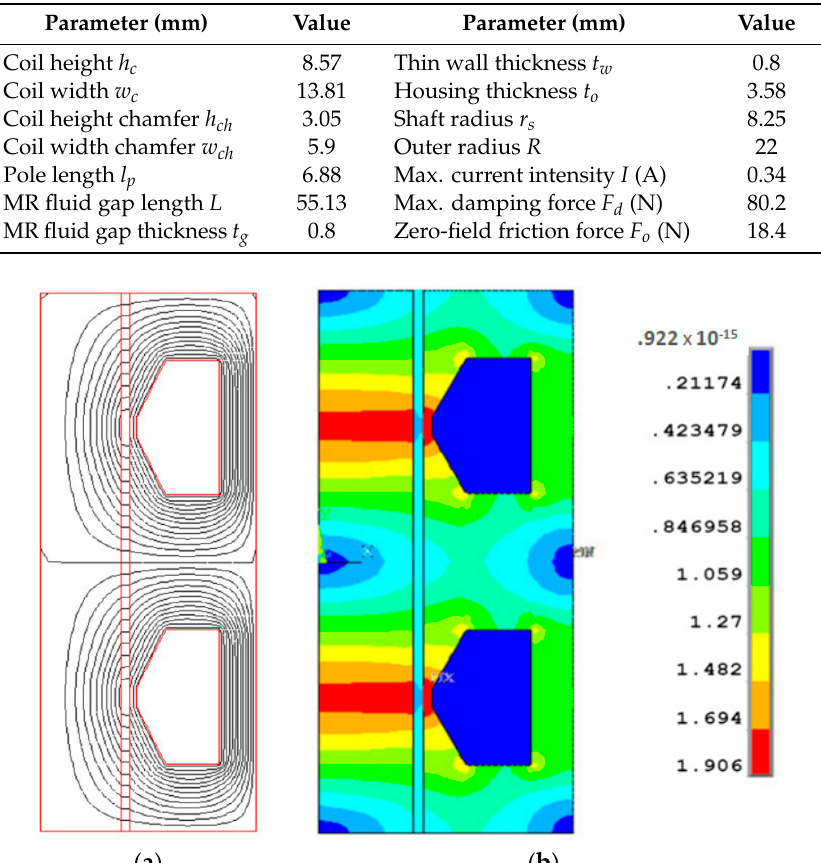
Figure 10. Finite element analysis of the optimized MR damping part: ( a ) magnetic flux line and ( b ) magnetic flux density.